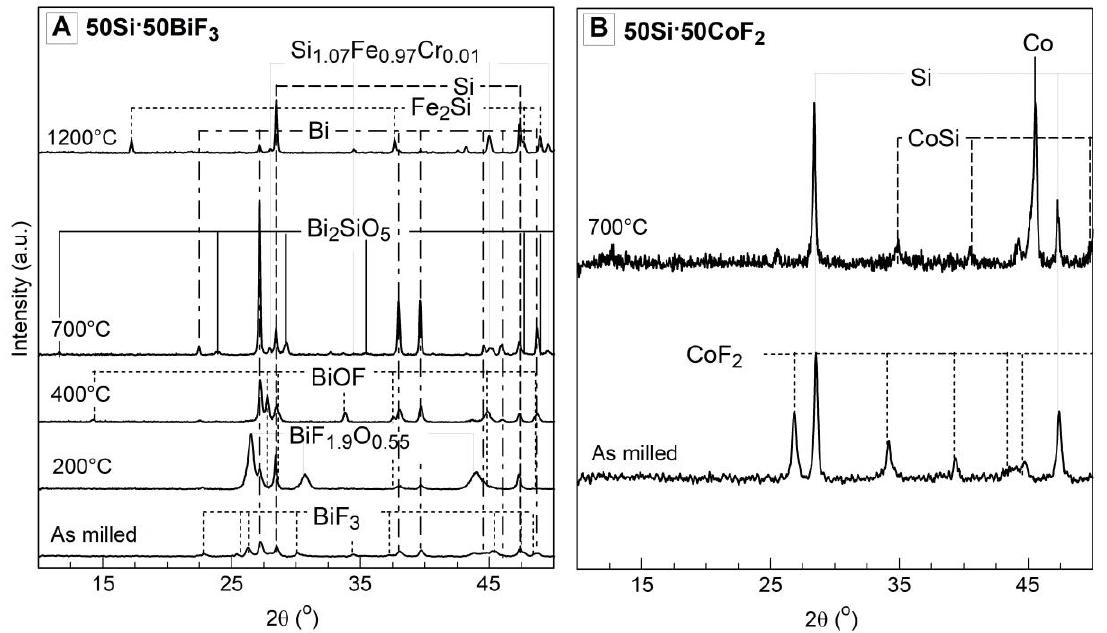
Figure 8. The XRD traces of the two-stage milled composites: ( A ) 50Si · 50BiF 3 and ( B ) 50Si · 50CoF 2 heated at 5 K/min in Ar and quenched at different temperatures.